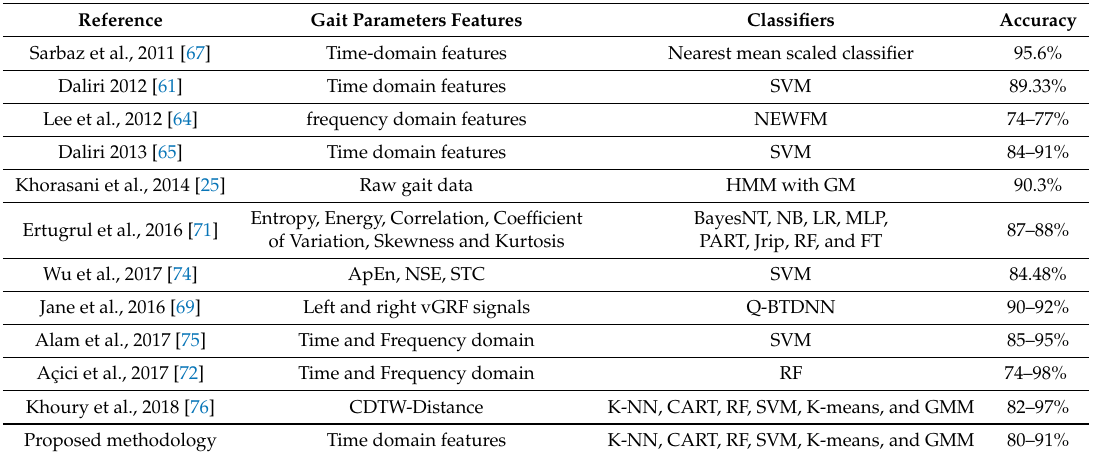
Table 11. Classification accuracy results obtained in recent related studies based on PhysioNet